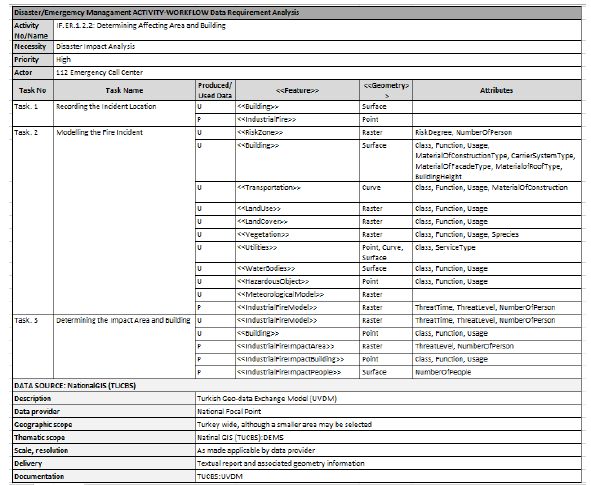
(Figure 5-a). Data requirement analysis for “Determining Affecting Area and Building” task is shown in Table 2.